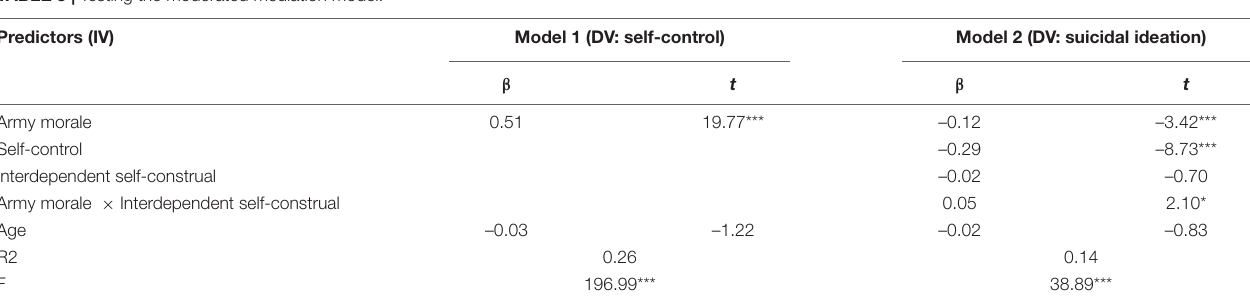
TABLE 3 | Testing the moderated mediation